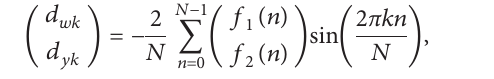
Figure 1: The phase portraits are displayed in (a) where solid blue lines are numerical results, ∗ results of the HB-AFT method, and k � 0 . 75 ,T � 0 . 01 , α � 0 . 125 , β � 0 . 5 ,C � 100 ,b � 50 , and b � 450. l 1 and p � 0 . 4, respectively. The comparisons of amplitudes of w in the numerical simulations and the first-order harmonic amplitudes of w by HB-AFT are presented in (b) where the solid blue line is the amplitude of numerical simulations and red ° are the first-order harmonic